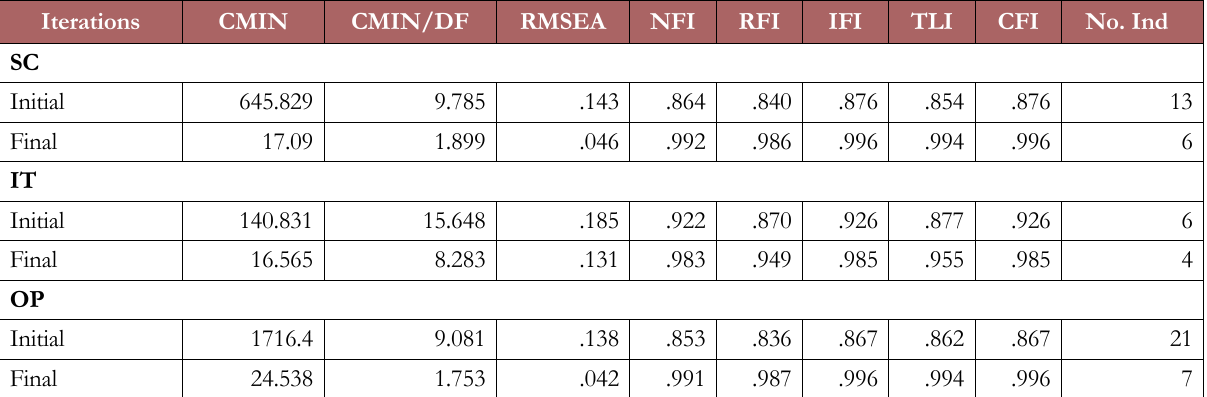
Table 3. Fit indices and non-standardized coefficients for the iterations of the CFA for the dimensions of SC, IT, and OP The data in Table 4 show that, due to the CFA, six SC items were significant with impact values greater than 0.59, 4 IT indicators had values greater than 0.65, and seven OP items were more outstanding than 0.50.